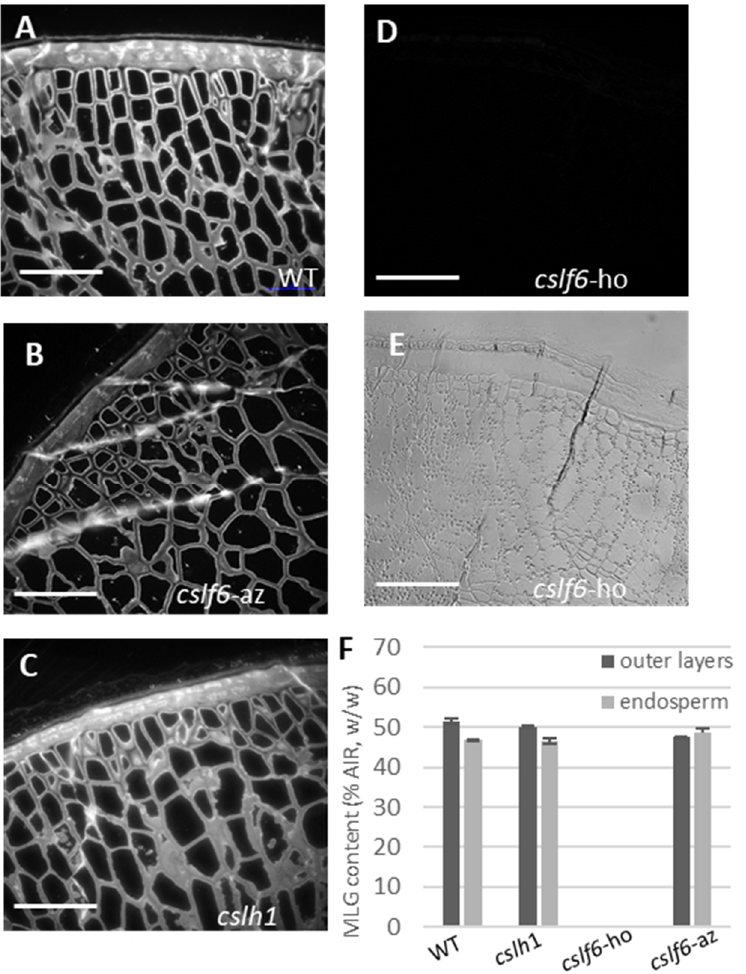
Figure 7. ( A – D ): Fluorescence immunolabeling of MLG in a grain cross-section of WT, cslh1 , azygous (az), and homozygous (ho) cslf6 mutants (15 days after flowering). The homozygous cslf6 ( cslf6 -ho) does not show any fluorescence signal ( D ). ( E ): Differential interference contrast of the cslf6 -ho mutant. Scale bar = 50 µm. ( F ): MLG content in the endosperm and pericarp of WT and mutant grains (15 days after flowering) expressed as a percentage of AIR ( w / w ). Table 2. Sugar composition of alcohol insoluble residues (AIR) of whole grains compared to sepa- rated endosperm and outer layers of cslh1 and cslf6 mutants and controls (WT and azygous cslf6 ) determined by gas chromatography analysis. Determination of starch and MLG content was carried out by HPAEC analysis. The results are expressed as a percentage of AIR dry matter. cslf6 -ho: ho-